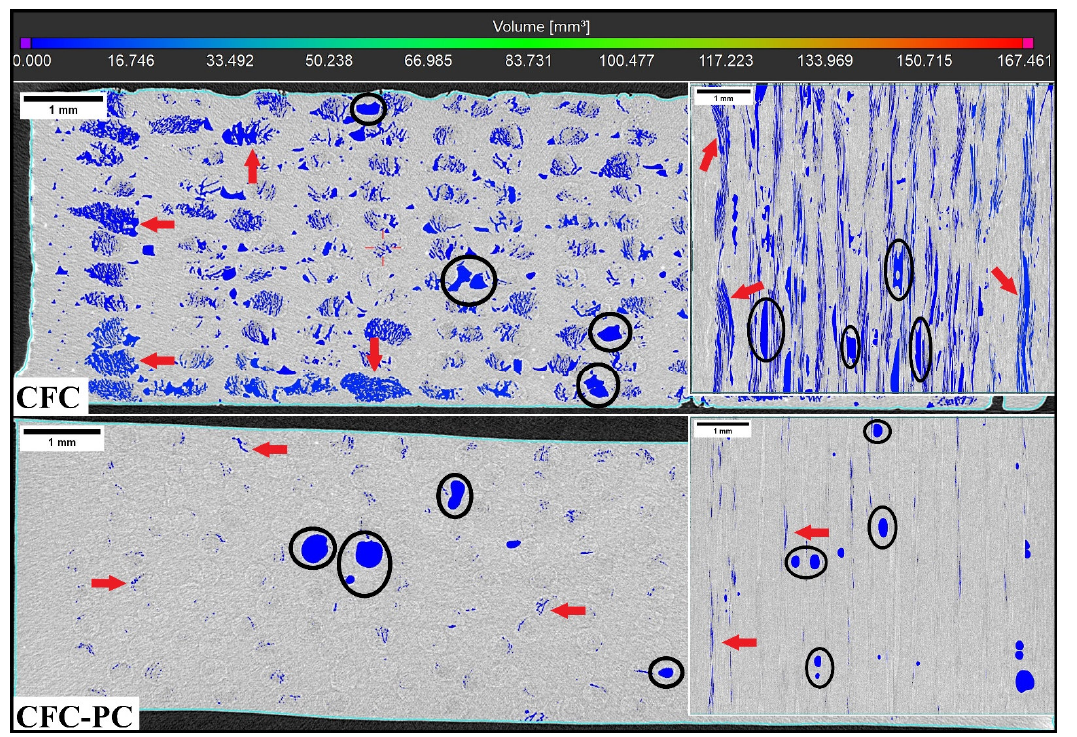
Figure 3. Top midsection CT images (X-Y) of the N-PLA with corresponding side midsection inset views (X-Z). A black circle is indicative of voids due to the thermoplastic matrix and red arrows showed voids within the CFC processed CCF.